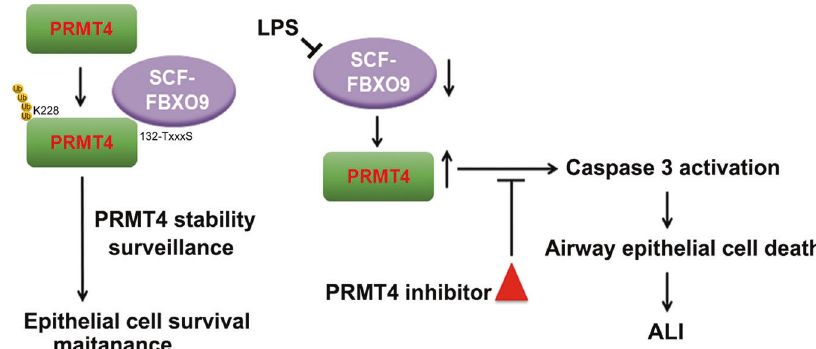
Fig. 8 Schematic presentation of the role of PRMT4 and SCF FBXO9 in airway cell death. Left: PRMT4 is normally degraded via a SCF FBXO9 E3 ligase-mediated ubiquitin proteasomal pathway to maintain airway epithelial cell survival. SCF FBXO9 recognizes PRMT4 via a phosphodegron and poly-ubiquitinates PRMT4 at K228. Bacterial endotoxin reduces FBXO9 levels that results in PRMT4 protein accumulation. Increased PRMT4 activates caspase 3 to induce lung epithelial apoptosis during bacterial